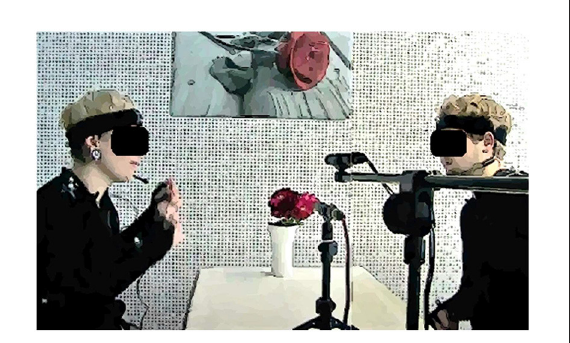
FIGURE1 Laboratory setting during the experiments showing participants during a conversation (both participants were wearing head-mounted microphones, motion capture jackets and headbands, the respiratory belt was worn underneath the